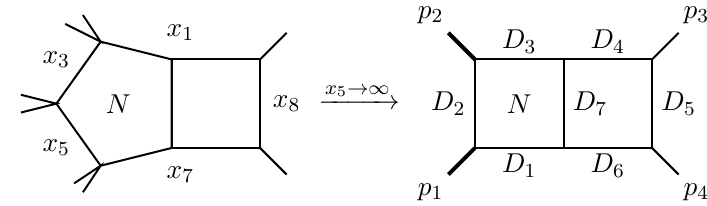
Figure 2 . The penta-box integral of interest and the corresponding non-DCI double-box integral. Here N represents a factor x 2 in the numerator of both 0 , 8